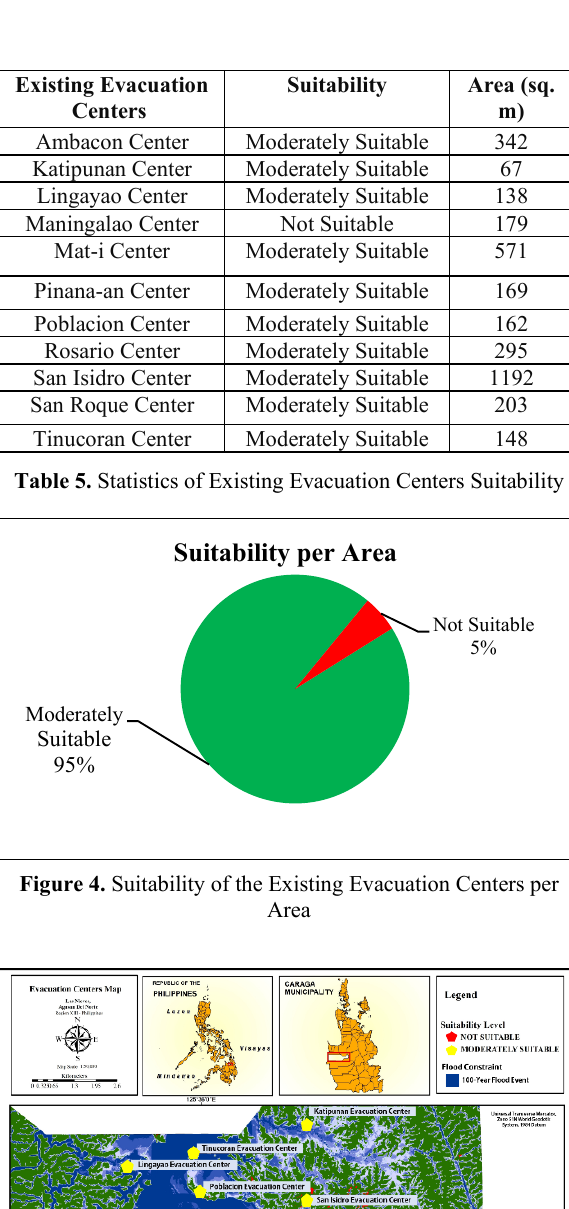
Table 4. Statistics of Highly Suitable Area per Barangay